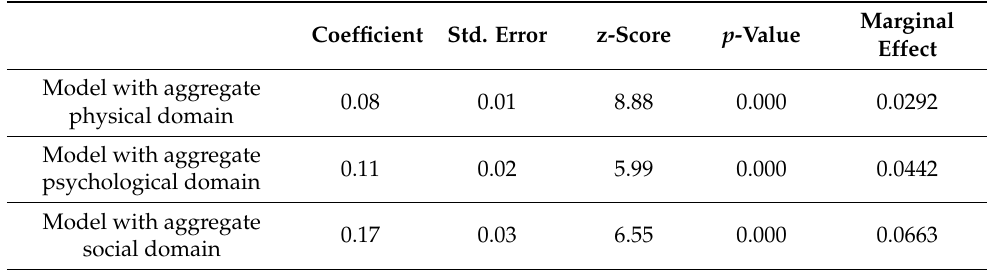
Table 3. Probit models for effects of physical, psychological and social domains on heart failure occurrence. Parameters, significance levels and marginal effects of the three probit models describe the change in probability of heart failure at the mean value of the frailty subscale.